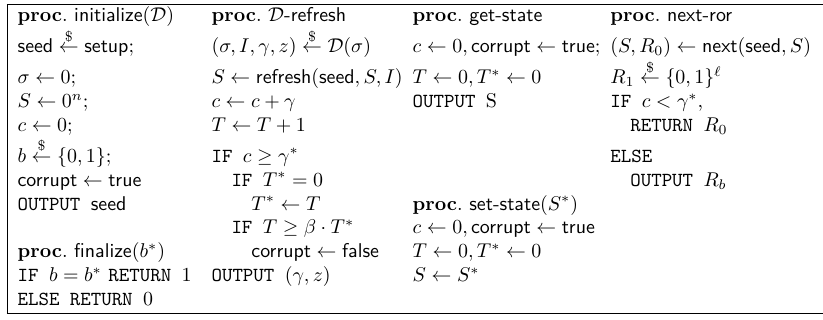
Figure 20: Procedures in Security Game NROB ( γ ∗ , β )